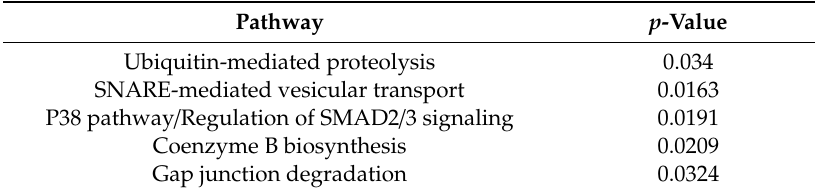
Table 2. KEGG pathway analysis of microarray data using DAVID and IMPaLA.